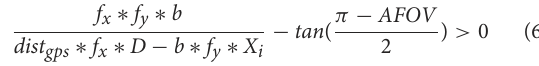
(Equations 2–5) was reformulated as Equation